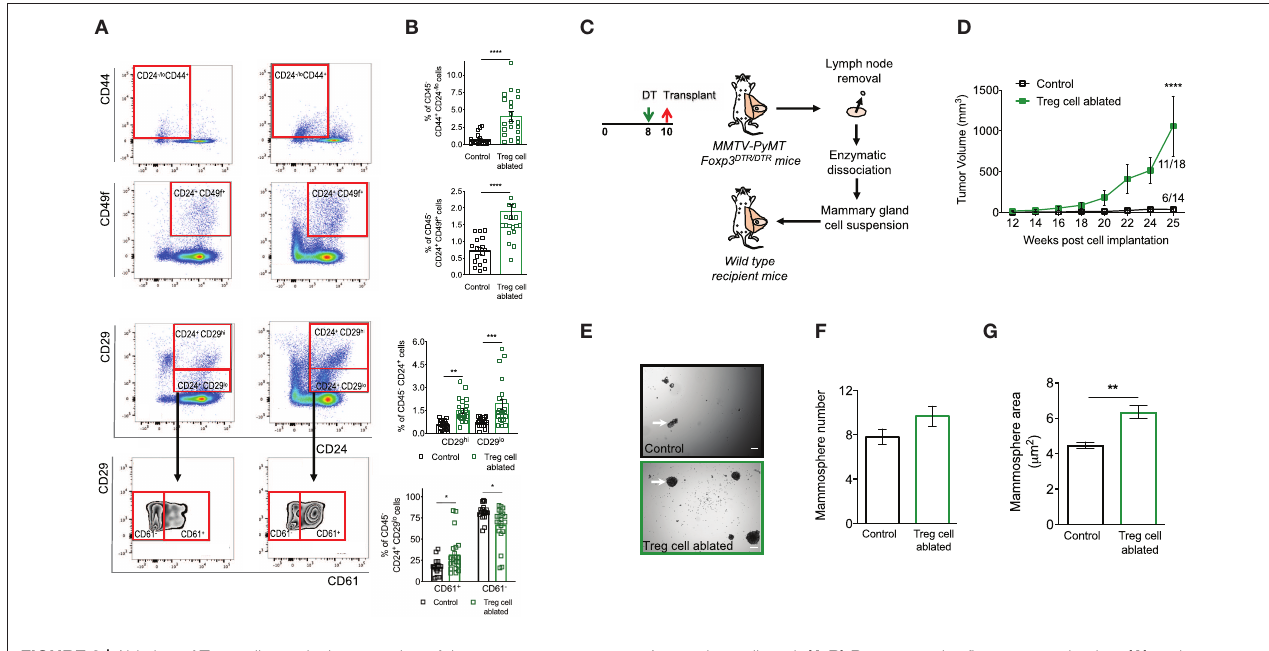
FIGURE 3 | Ablation of Treg cells results in expansion of the mammary cancer stem/progenitor cell pool. (A,B) Representative flow cytometric plots (A) and quantification (B) of stem cell like-populations (CD24 − / lo CD44 + , CD24 + CD49f + , CD24 + CD29 hi ) and luminal progenitor-enriched population (CD24 + CD29 lo ) of Treg cell-ablated and control mice. Gating on the luminal progenitor-enriched population, we compared immature (CD61 + ) and differentiated luminal progenitors (CD61 − ) between both groups (bottom). Indicated cell populations highlighted with red frames. Values are expressed as mean ± SEM, control n = 11, Treg cell ablated n = 12, **** p < 0.0001, and was calculated by Mann-Whitney test. ** p = 0.0045; *** p = 0.0003; * p = 0.0237; * p = 0.0219 was calculated by two-way ANOVA, followed by Bonferroni’s post-hoc test. Data were pooled from four independent experiments. (C,D) Schematics (C) and tumor growth kinetics (D) of mice orthotopically transplanted with dissociated mammary epithelial cells. Values expressed as mean ± SEM. **** p < 0.0001 by two-way ANOVA, followed by Bonferroni’s post-hoc test (D) . (E–G) In vitro mammosphere forming capacity of CD45 depleted-mammary cells. Representative images (E) , mammosphere number (F) and area (G) of control (black) and Treg cell-ablated (green) conditions ( n = 16 and n = 13, respectively). Arrow depicts a representative mammosphere in each image. Scale bar represents 200 µ m. Values are expressed as mean ± SEM. ** p = 0.0069 was calculated by Mann-Whitney test. Data were pooled from five independent experiments. the mammary gland tissue of Treg cell-ablated mice ( Figure 4B